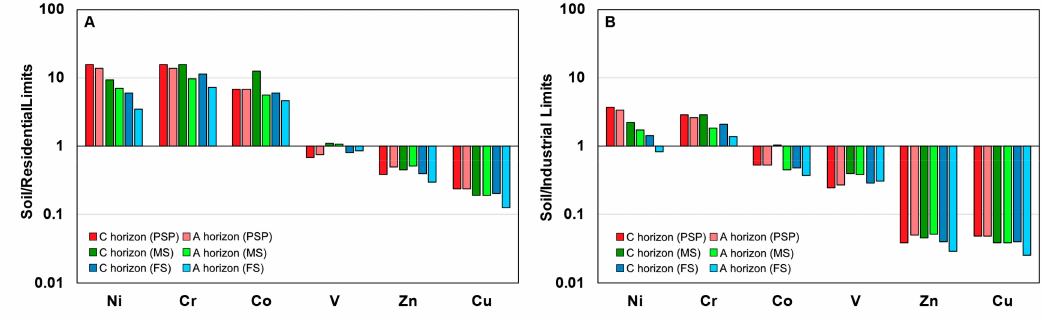
Figure 8. PTEs content normalized to Italian threshold values for residential ( A ) and industrial ( B ) sites according to Italian law (D.M. 471 / 1999 [92]; D.Lgs 152 / 2006